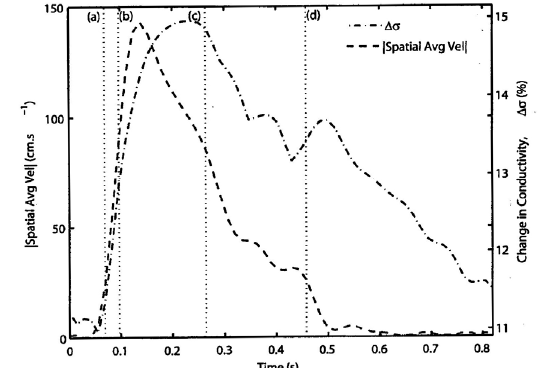
Fig. 4. Absolute spatial average velocity (i.e. reduced average velocity < v >/R, s –1 ) vs. conductivity change in an in vitro pulsatile ejection model over one cardiac cycle. Note that, upon red cell acceleration in early ejection, the peak rate of change of the reduced average velocity parallels the peak rate of change of conductivity (r = 0.99). From reference